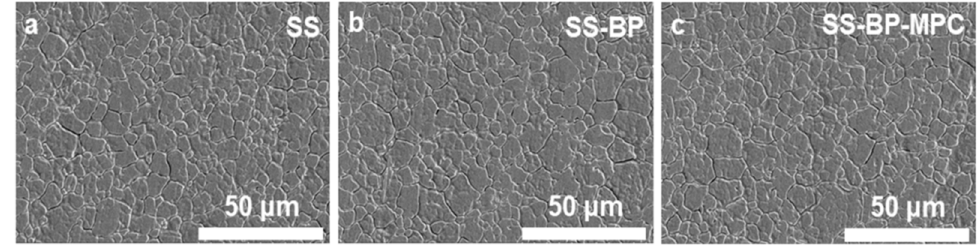
Figure 2. Field emission scanning electron microscopic (FESEM) images for ( a ) pristine SS substrate, ( b ) SS-BP, and ( c ) SS-BP-MPC composites.